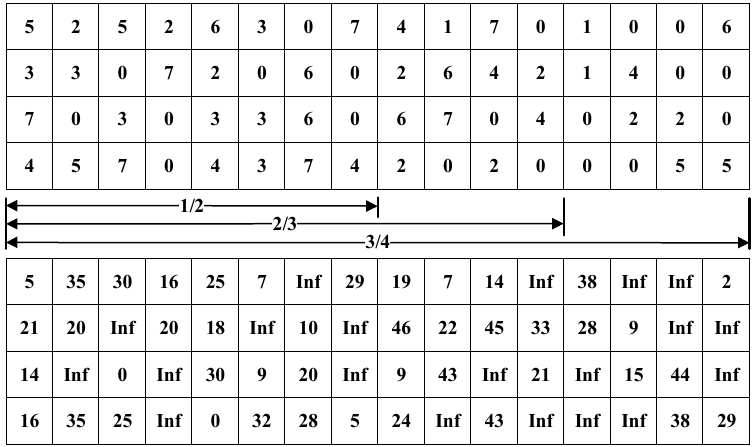
Figure 3. Check matrix H structure of the NB-LDPC codes.